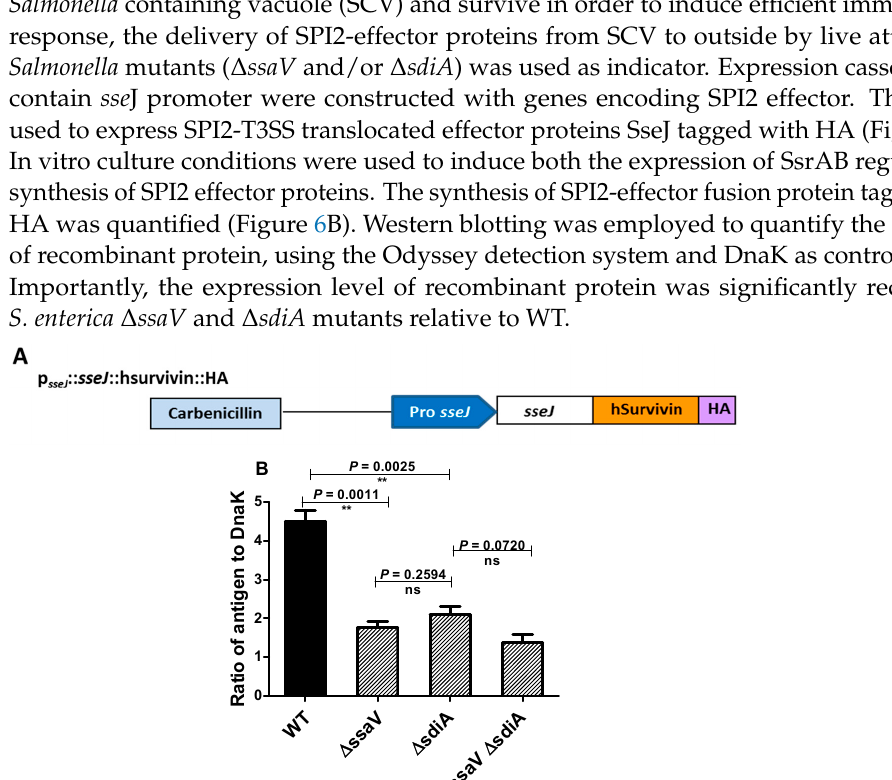
Figure 5. Intercellular survival of S. enterica strains in HeLa cells and raw macrophages. S. enterica WT, ∆ ssaV , ∆ sdiA and ∆ ssaV ∆ sdiA strains were cultured in suitable conditions to induce SPI1 genes. Bacterial strains were used to infect HeLa cells or raw macrophages in multiplicity of infection (MOI of 1). Non-internalized bacteria were removed by washing with PBS, and remaining extracellular bacteria were killed by using gentamicin (100 µ g/mL). ( A ) Invasion assays; Hela cells were lysed with 0.1% Triton X-100 after 1 h infection, and intracellular bacteria were counted. The number of invading bacteria (1 h versus inoculum) was calculated. ( B ) Intracellular replication assays; infected cells were lysed with 0.1% Triton-X-100, and intracellular bacteria were counted at 2 and 16 h post-infection. Assays were performed in triplicate, and results were expressed as means ± standard deviations; p -value < 0.05 was considered statistically significant, using a two-tailed t -test (*** = p < 0.001; **= p < 0.01)